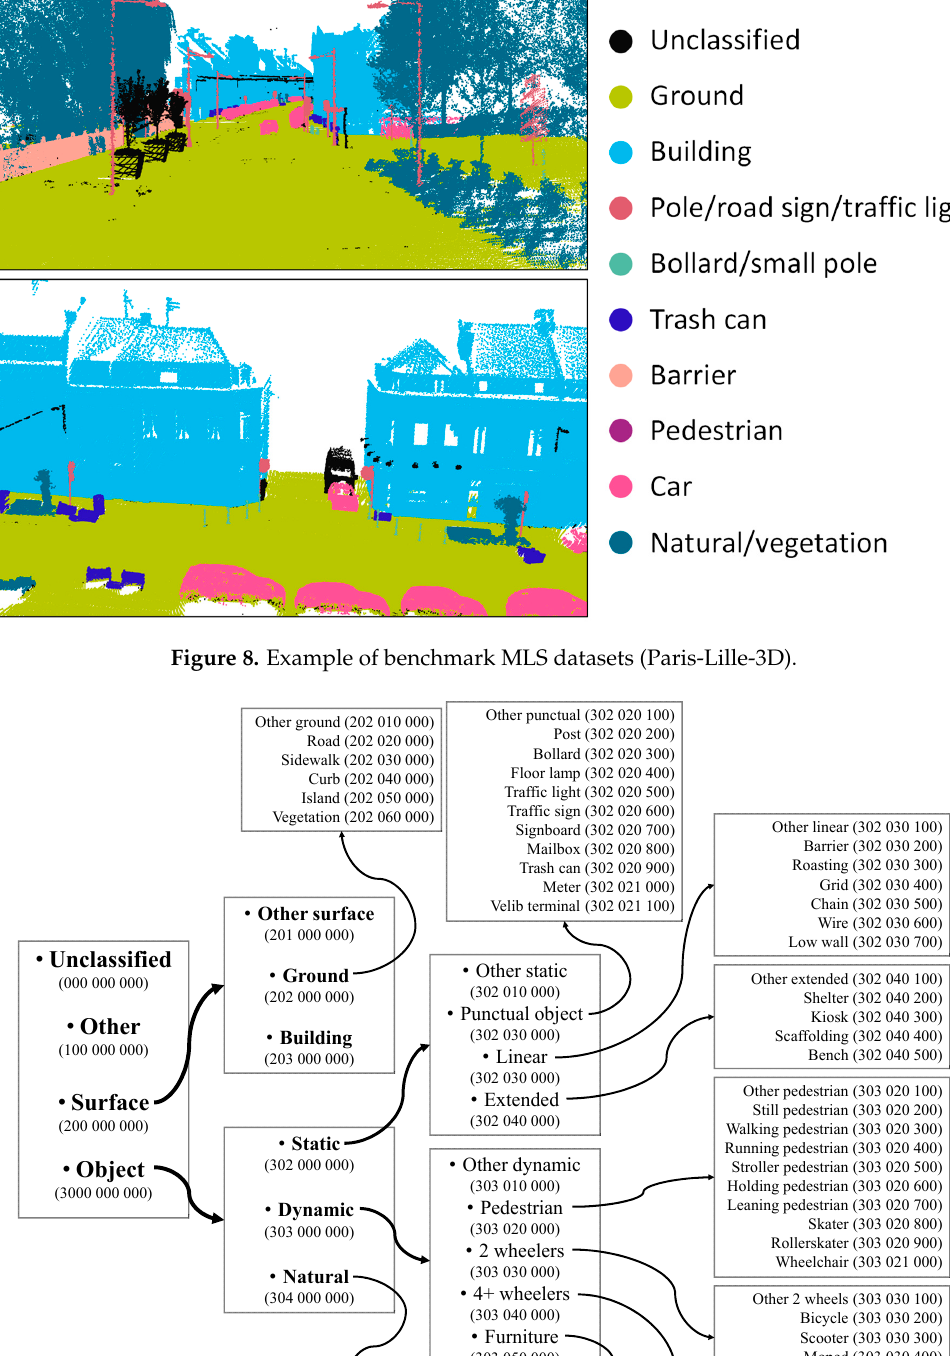
datasets with the class ID provided. with the class ID